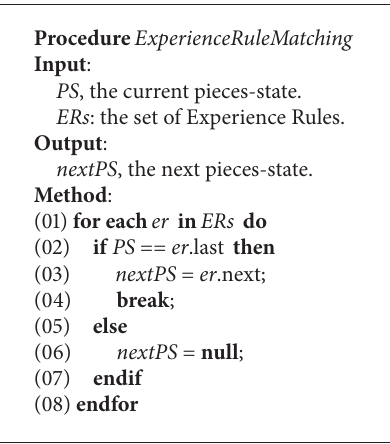
Algorithm 6: ExperienceRuleMatching .